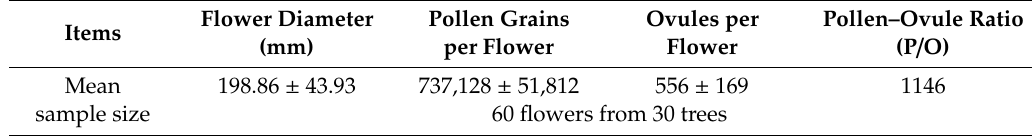
Table 5. Outcrossing index of M. conifera.